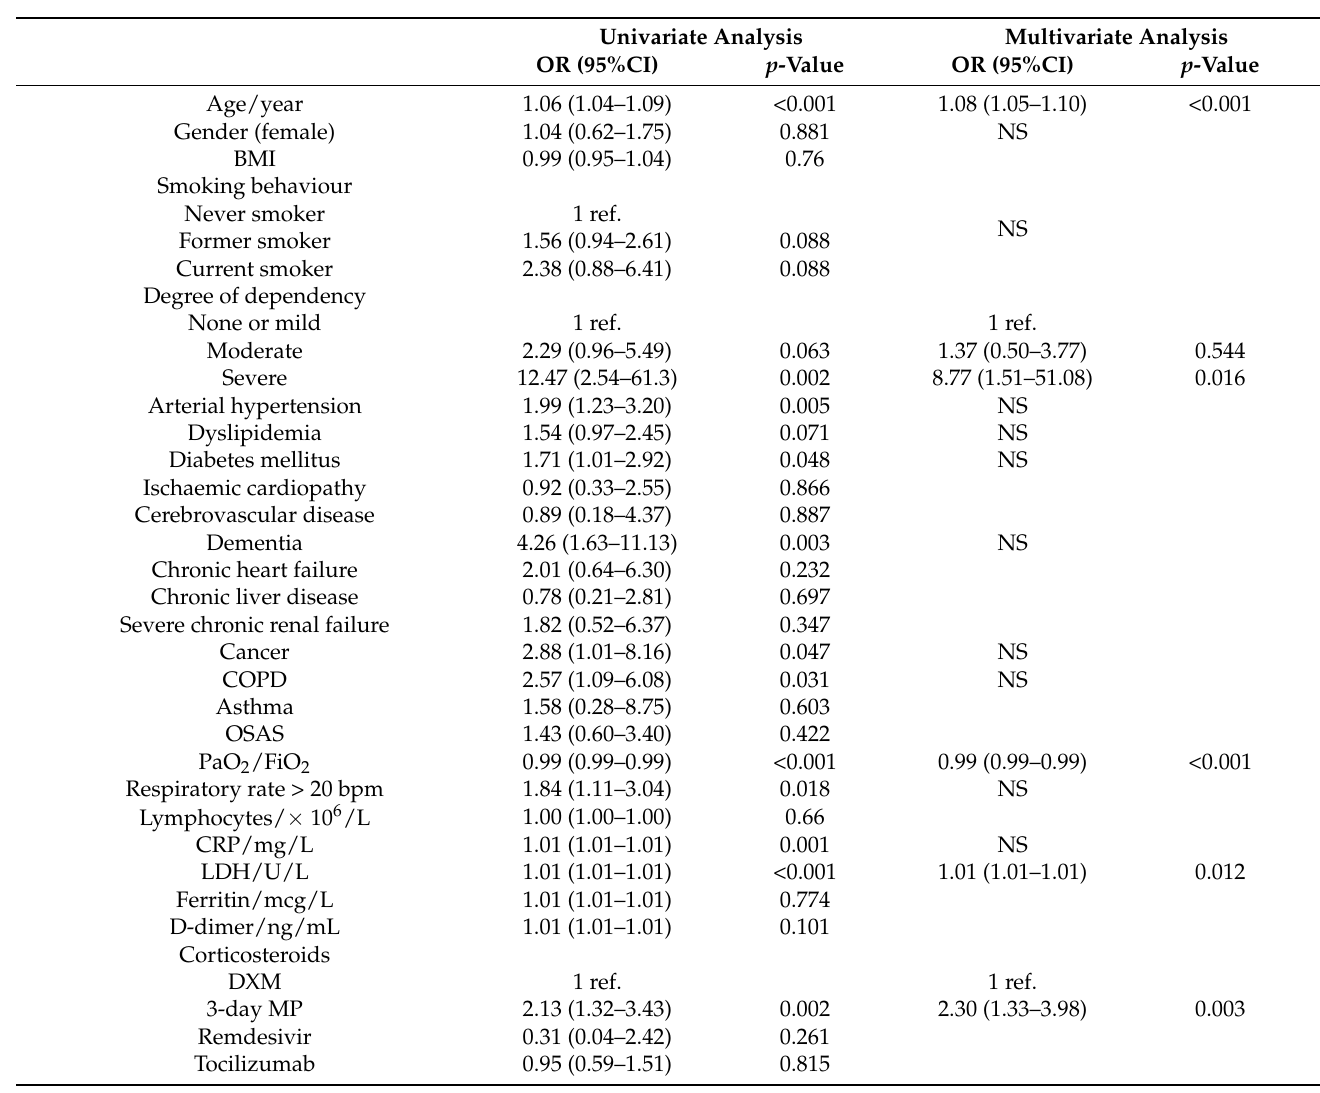
Table 6. Risk factors for in-hospital mortality in the matched